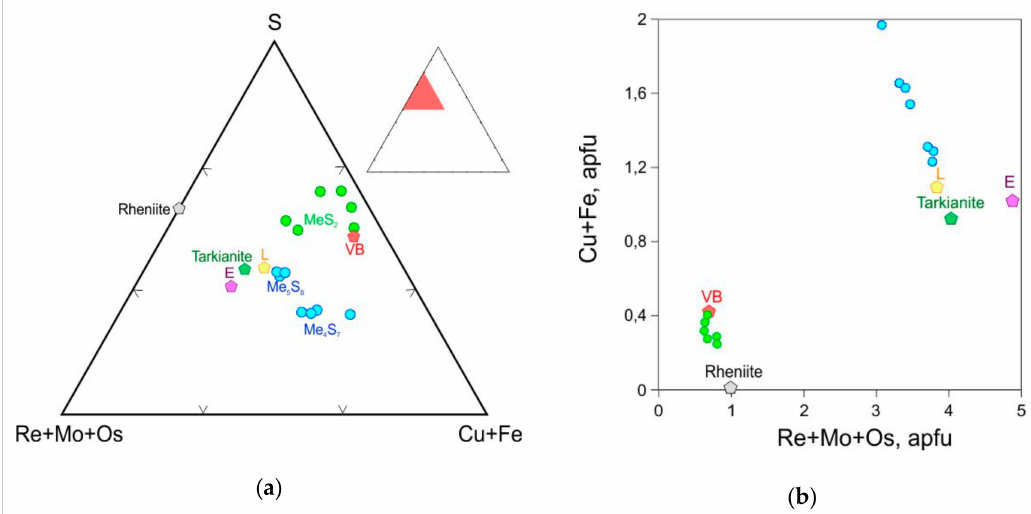
Figure 4. Chemical composition of Re sulfides plotted as: ( a ) the ternary plot (Cu + Fe + Ni + Co)–(Re + Os + Mo)–S (at.%); ( b ) the binary plot of (Re + Mo + Os) vs. (Cu + Fe) (atoms per formula unit). Symbol used: blue circle—Zhelos; green circle—Tokty-Oi; E: Ekojoki; L: Lukkulisvaara; VB: Voronov